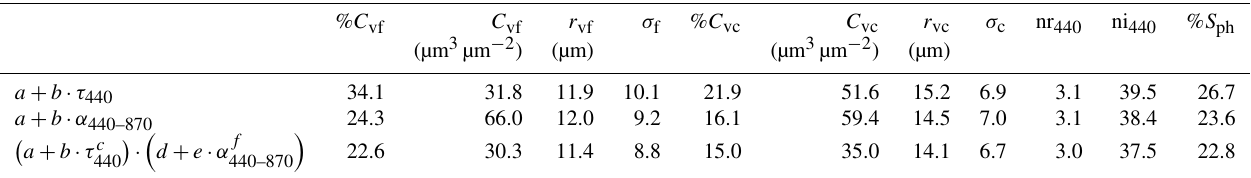
Table 4. Mean relative uncertainties (in percent) for each retrieved aerosol microphysical properties modeled using several mathematical formulations over the whole dataset.